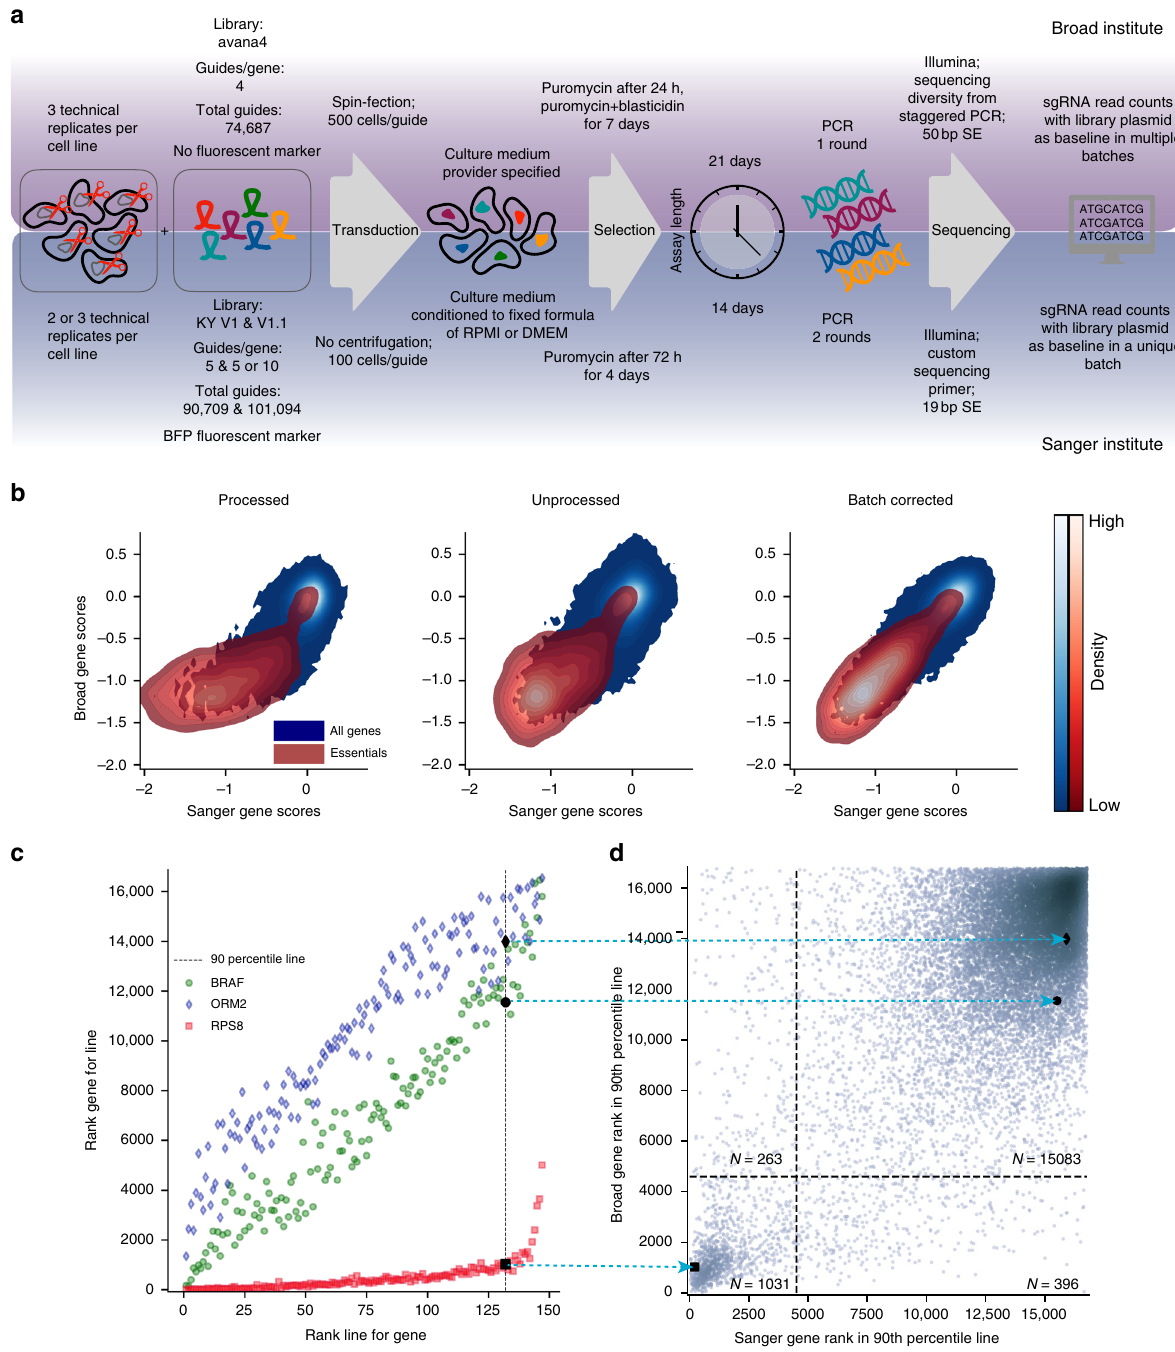
Fig. 1 Comparison of experimental protocols and gene score results. a Experimental settings and reagents used in the experimental pipelines underlying the two compared data sets. b Densities of individual gene scores in individual cell lines, in the Broad and Sanger data sets, across processing levels. The distributions of gene scores for previously identi fi ed essential genes 12 are shown in red. c Examples of the relationship between a gene ’ s score rank in a cell line and the cell line ’ s rank for that gene using Broad unprocessed gene scores, with gene ranks in their 90th percentile of least dependent lines highlighted. Cell lines in the 90th percentile of least dependent lines on RPS8 (a common essential gene) still rank this gene among the strongest of their dependencies. d Distribution of gene ranks for the 90th percentile of least dependent cell lines for each gene in both data sets. Black dotted lines indicate natural thresholds at the minimum gene density along each axis. The y -axis is equivalent to the y -axis in ( c ) at the 90th percentile mark, as indicated by the arrows.